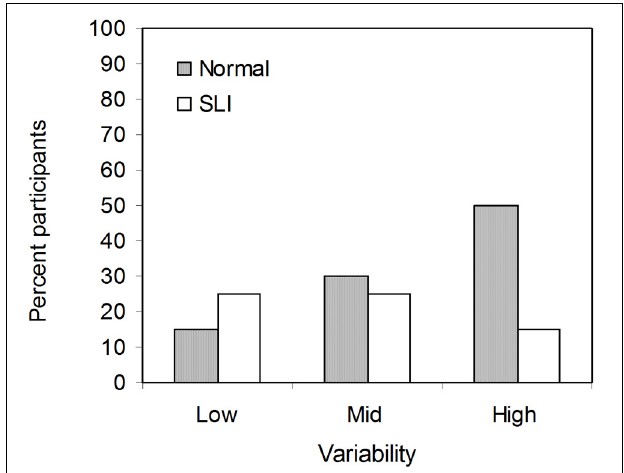
FIGURE 3 | Percent participants in the NL and the SLI group learned at least one non-adjacent pairs in the low, mid, and high variability conditions.